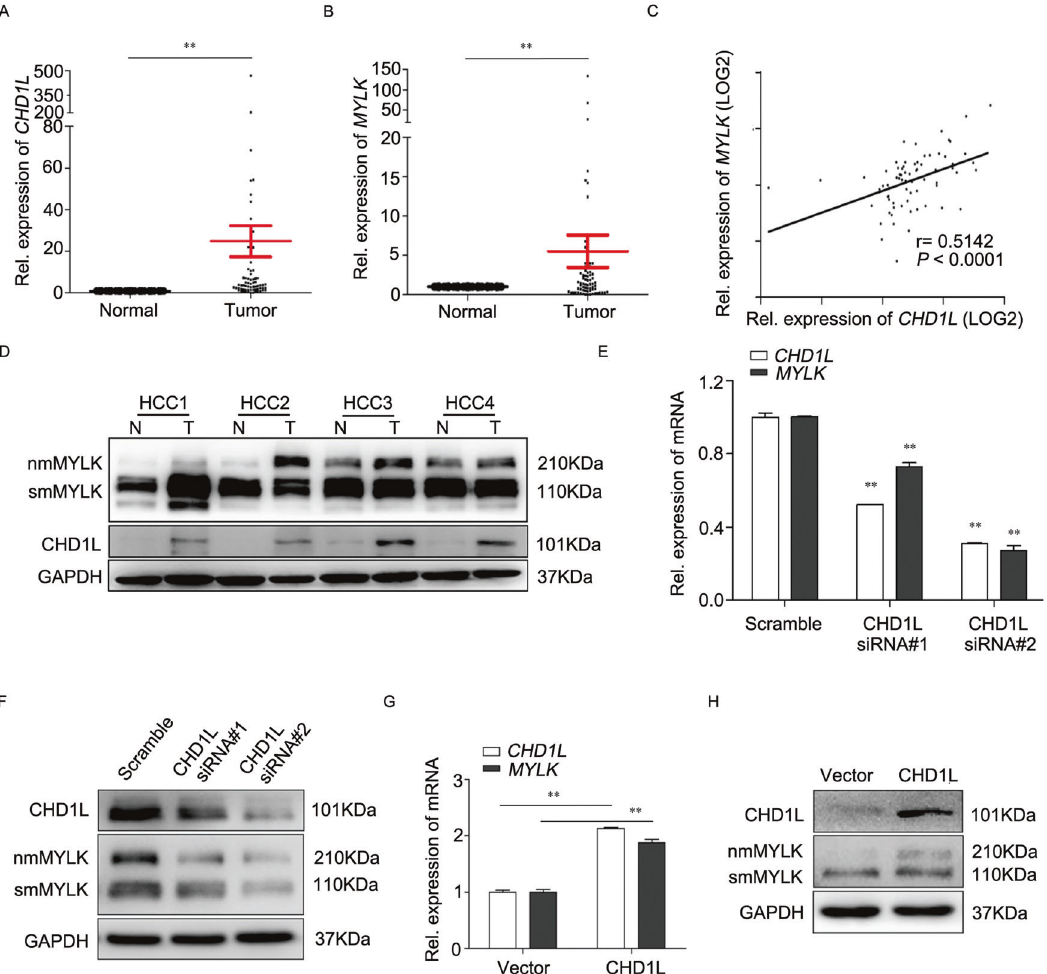
Fig. 1 CHD1L promotes nmMYLK expression in HCC. A, B Quantitative RT-PCR (qRT-PCR) analysis for CHD1L and MYLK in 73 pairs of HCC tumors (T) and adjacent nontumor tissues (N). Data shown as mean ± SD. C Spearman correlation analysis for the expression of CHD1L and MYLK (r = 0.5142, P < 0.0001), based on qRT-PCR results. D Western blot assay was used to detect the expression of CHD1L and MYLK in paired HCC samples, with GAPDH as normalized control. E, F The mRNA and protein levels of CHD1L and MYLK in HepG2 cells were detected with qRT-PCR and western blot after siCHD1L treatment, Data were performed by mean with SD from three independent experiments. G, H The mRNA and protein levels of CHD1L and MYLK in 7703 cells were detected using qRT-PCR and western blot. Data were performed by mean with SD from three independent experiments. ** P <